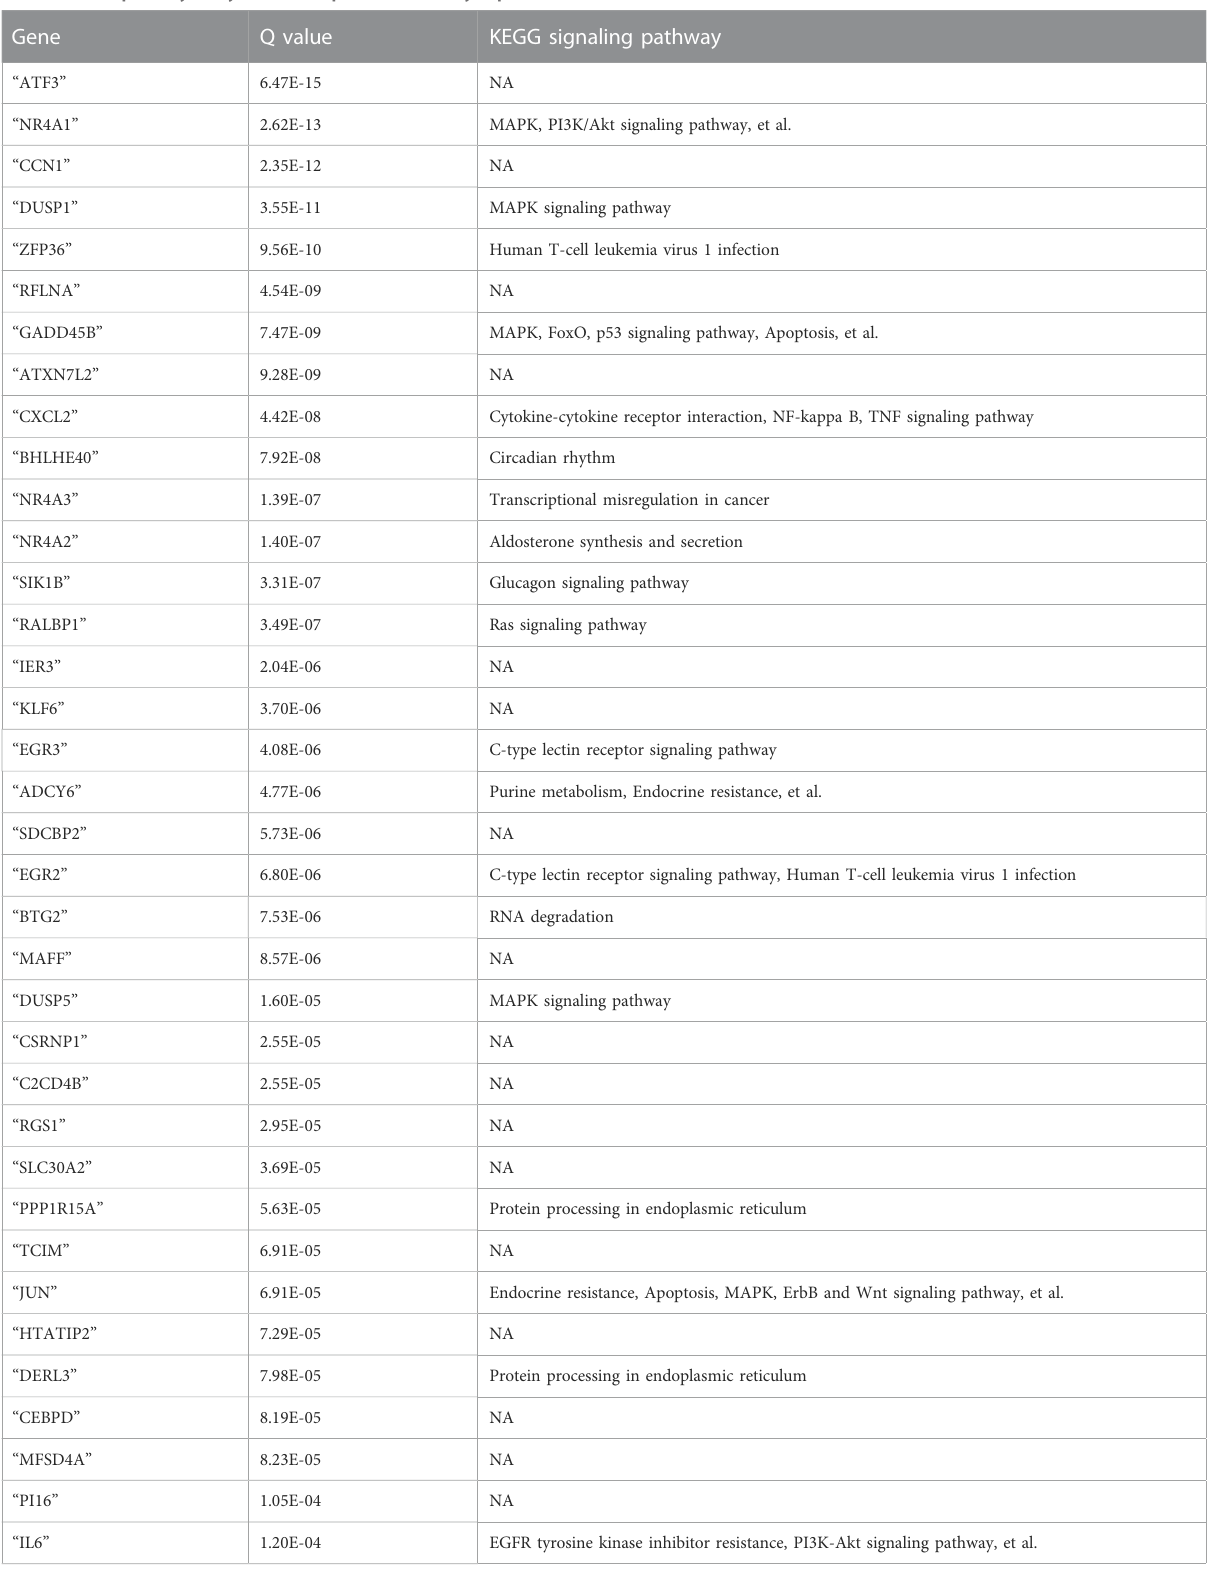
TABLE 3 KEGG pathway analysis of the top 50 differentially expressed miRNAs.